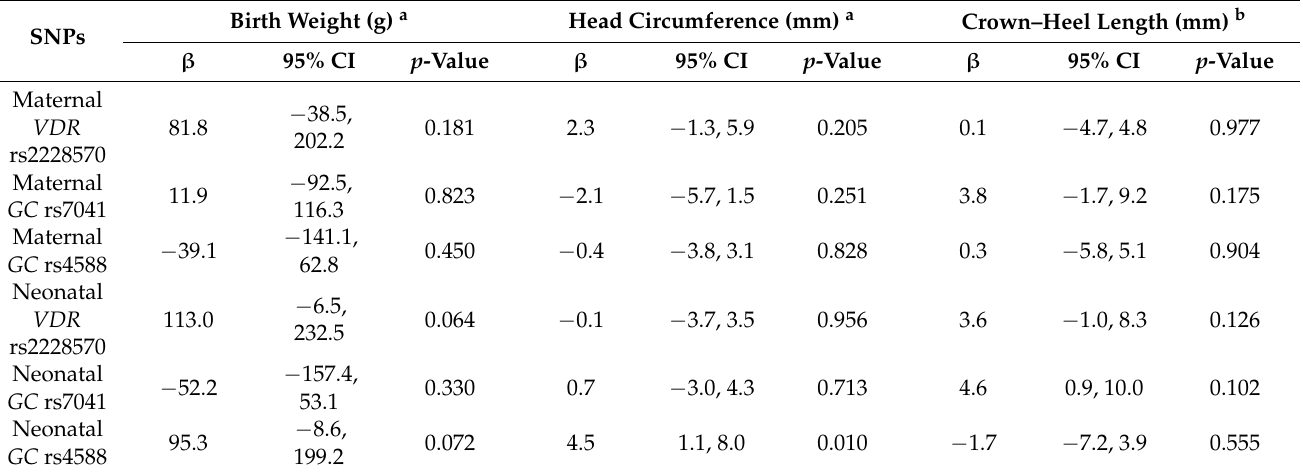
Table 4. Multivariate analysis of maternal and neonatal VDR and GC SNPs with birth outcomes.